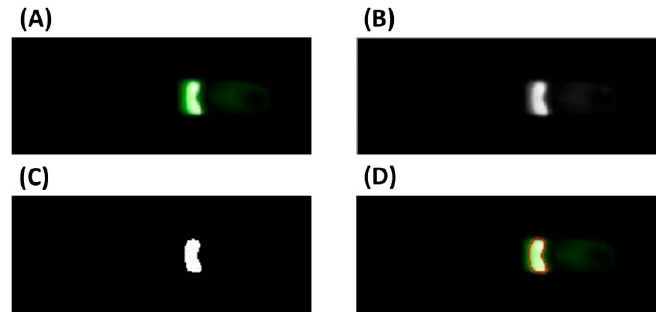
Figure 4. Image processing. ( A ) Original fluorescence image; ( B ) Converted gray image; ( C ) Converted binary image; ( D ) Marked fluorescence image.